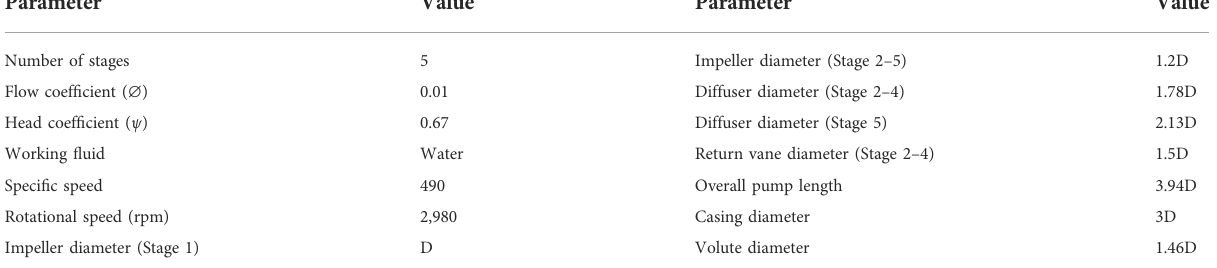
TABLE 1 Pump speci fi cation and